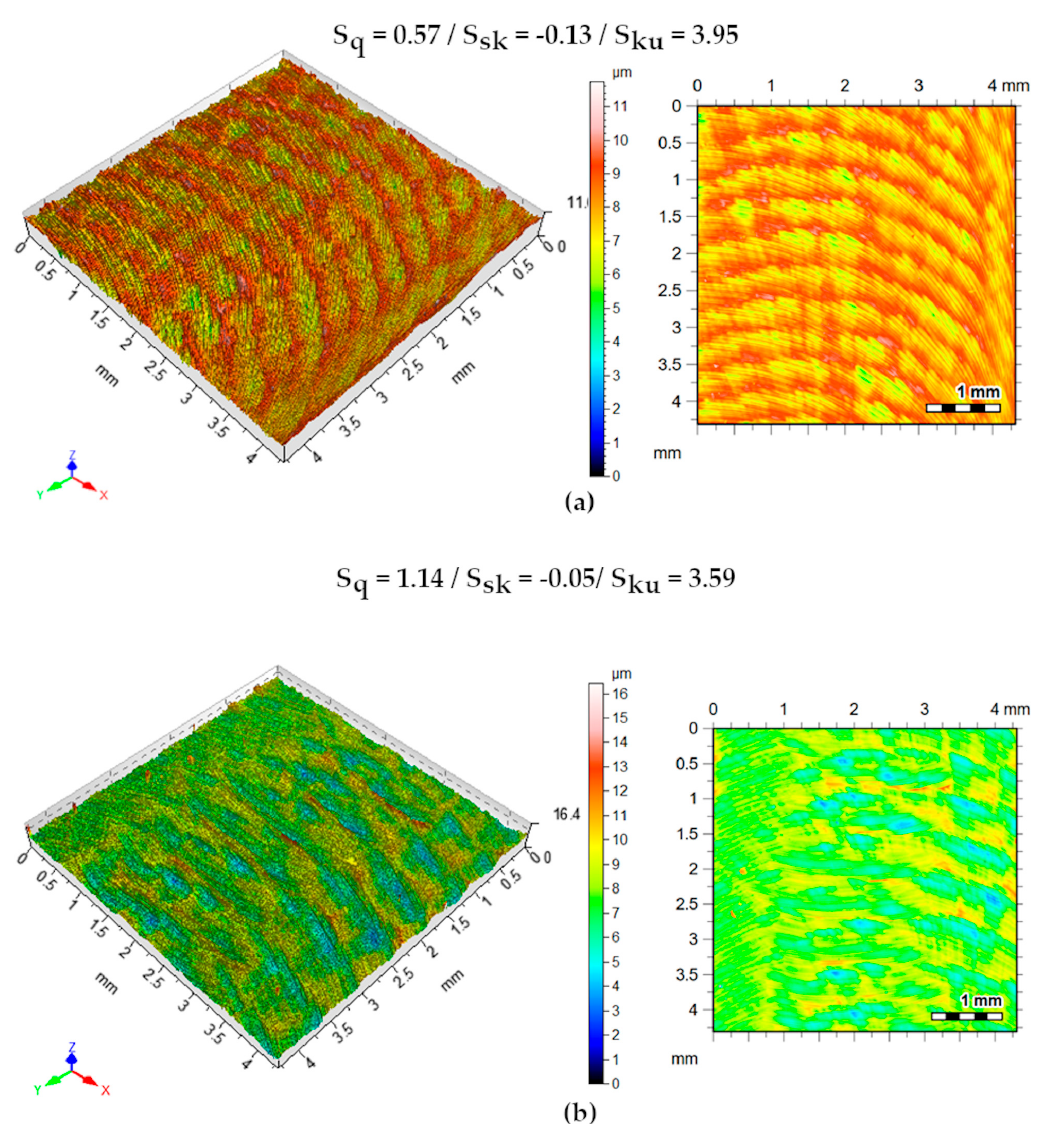
Figure 18. Machined surface topography. Isometric views and contour maps—dry strategy. ( a )v c = 80 Figure18. Machinedsurfacetopography. Isometricviewsandcontourmaps—drystrategy. ( a )v c = 80m / min, m/min, a p = 0.5 mm, f = 0.06 mm/rev.; ( b ) v c = 100 m/min, a p = 1.0 mm, f = 0.1 mm/rev. a p = 0.5 mm, f = 0.06 mm / rev.; ( b ) v c = 100 m / min, a p = 1.0 mm, f = 0.1 mm /